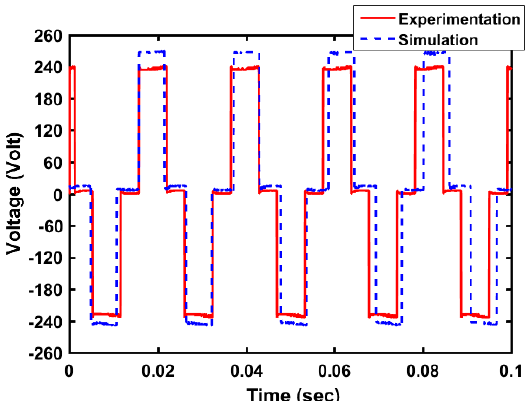
Figure 23. Comparison between simulation and experimental modified AC voltage.